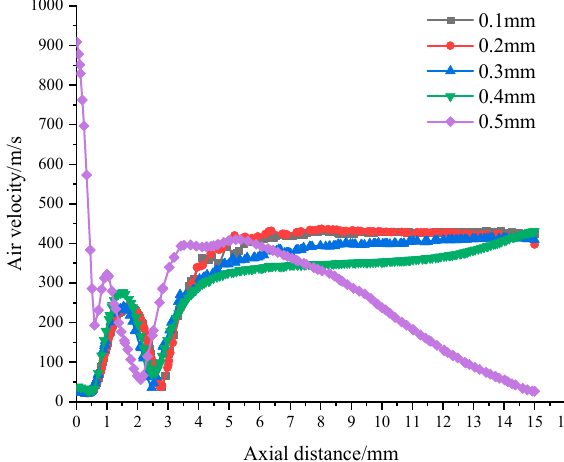
Figure 7. Air velocity of spray flow field under different initial mesh sizes.